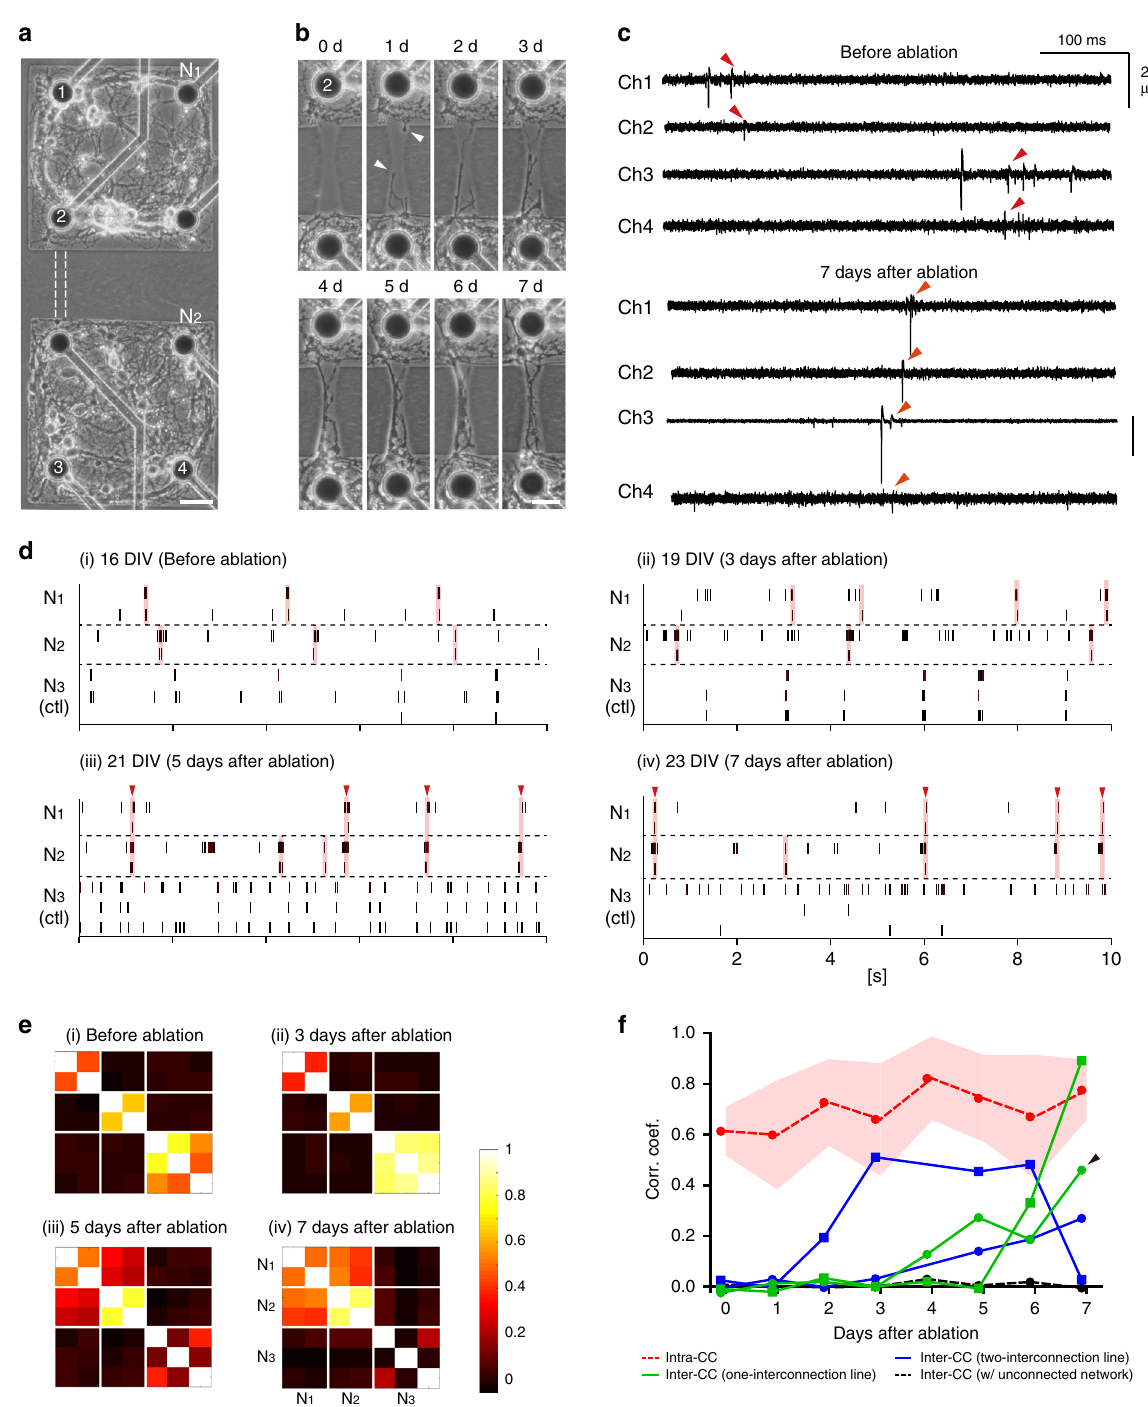
Fig. 3 Network synchronization by creating new neurite connections. a Phase-contrast image of neuronal networks at 16 DIV. Agarose micropatterns were 300 μ m by 300 μ m with a spacing of 100 μ m. Scale bar: 50 μ m. The image shown is representative of four independent experiments. b Neurite outgrowth into the interconnection line over time (d: days after ablation). Scale bar: 30 μ m. c Raw traces recorded from four electrodes (Ch1 and Ch2 in N 1 , Ch3 and Ch4 in N 2 ) before and 7 days after agarose ablation. Arrowheads indicate synchronized activities. d Raster plots before and 3, 5, 7 days after ablation. Pink shaded regions indicate synchronized activities within a 100 ms window. Red arrowheads indicate synchronized activities across N 1 and N 2 . e Representative correlation matrices before and 3, 5, 7 days after ablation process. f Mean correlation coef fi cients of four MEAs. Green and blue graphs show inter-CC between networks with one and two-interconnection lines, respectively, and each line represents an individual MEA. An arrowhead indicates the values of the MEA in Fig. 3e. The red graph and shaded region denote the mean and SD values of intra-CC from 4 MEAs, respectively. Source data are provided as a Source Data fi